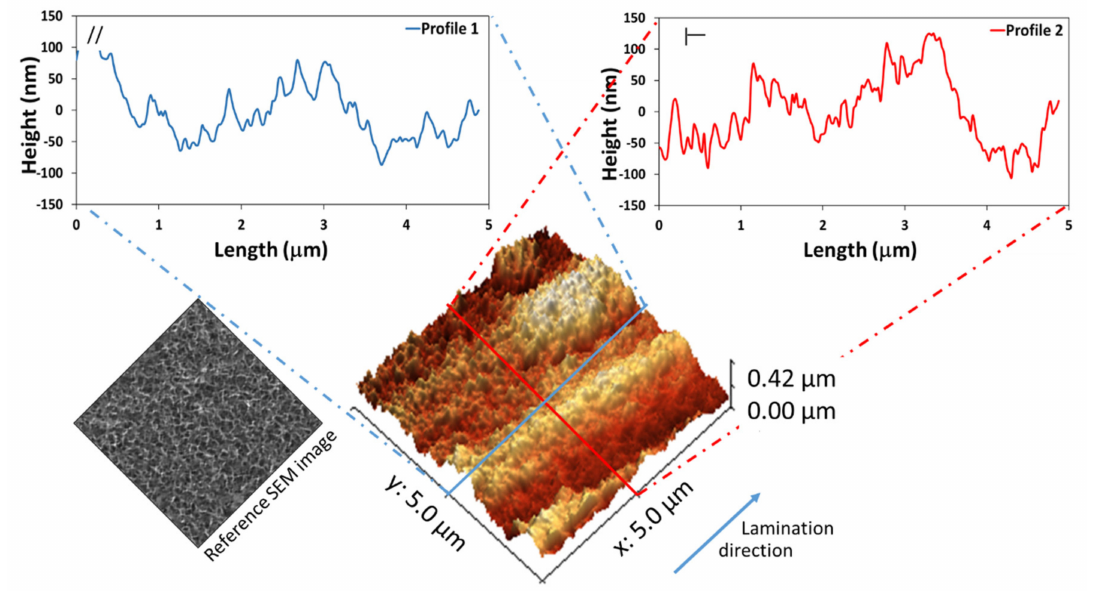
Figure 5. Three-dimensional AFM map and the two direction profiles of